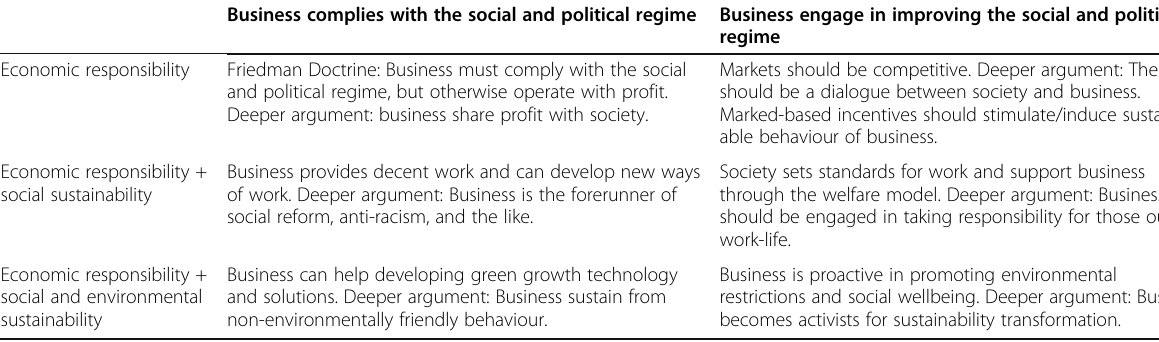
Table 1 Degree of comprehensiveness of CSR thinking Business complies with the social and political regime Business engage in improving the social and political